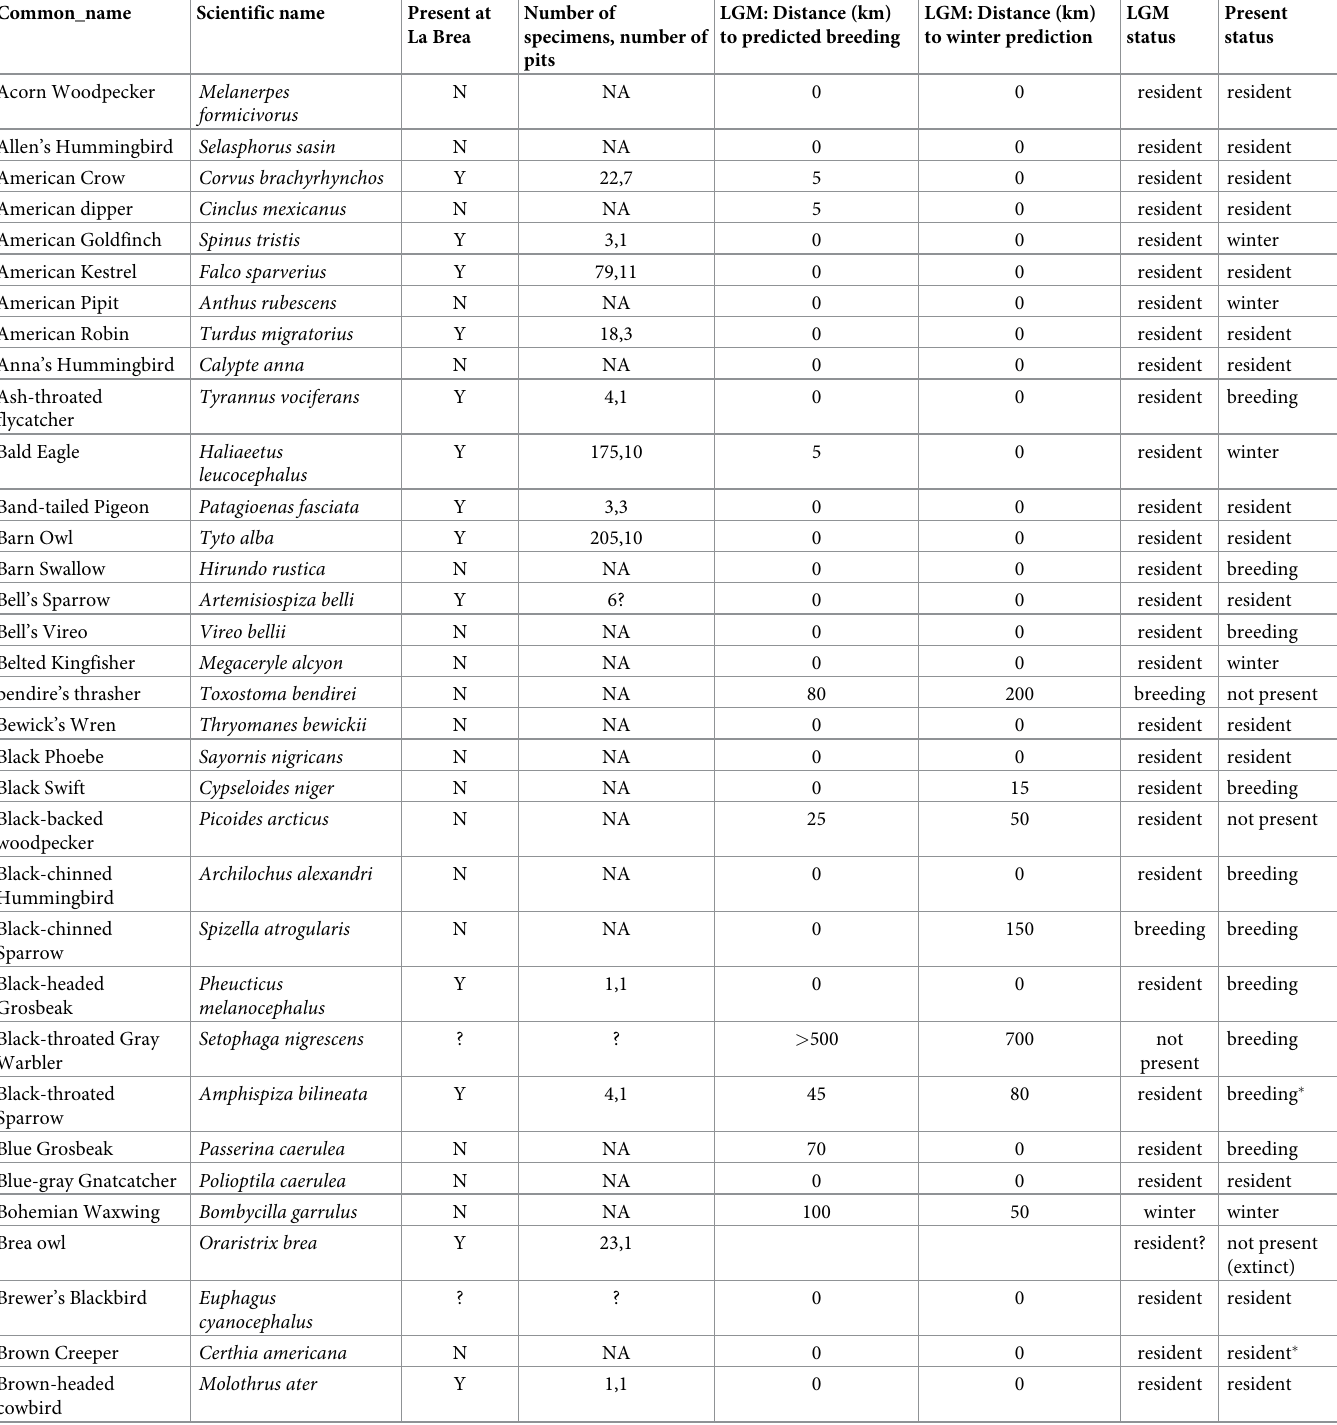
Table 1. List of species analyzed, presence in La Brea deposits, number of specimens and tar pit layers for each species, distance in km from La Brea to nearest pre- dicted breeding occurrence at Last Glacial Maximum, distance in km from La Brea to nearest predicted wintering occurrence at Last Glacial Maximum, residency status at La Brea at the Last Glacial Maximum, and present status at La Brea (within 100 km). An asterisk indicates that the condition shown is most probable given the